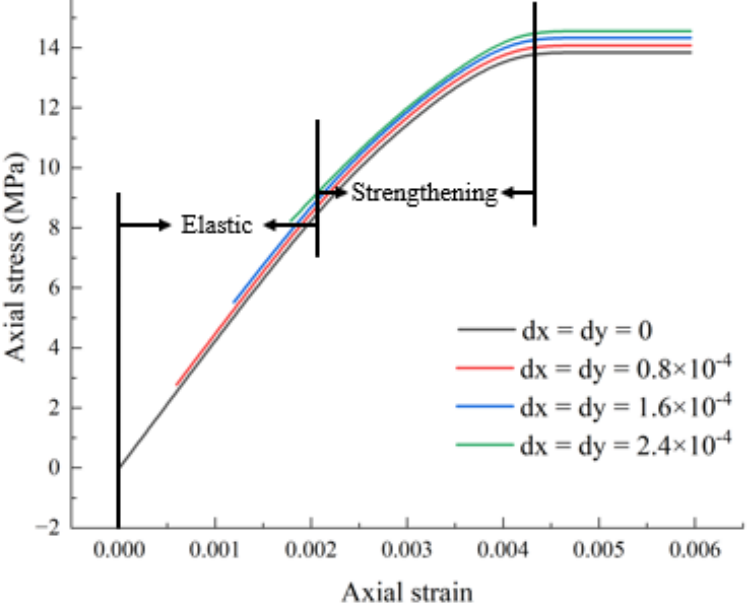
Figure 6. Simulation stress–strain curve of Case 7, where the elastic stage and strengthening stage can be seen.